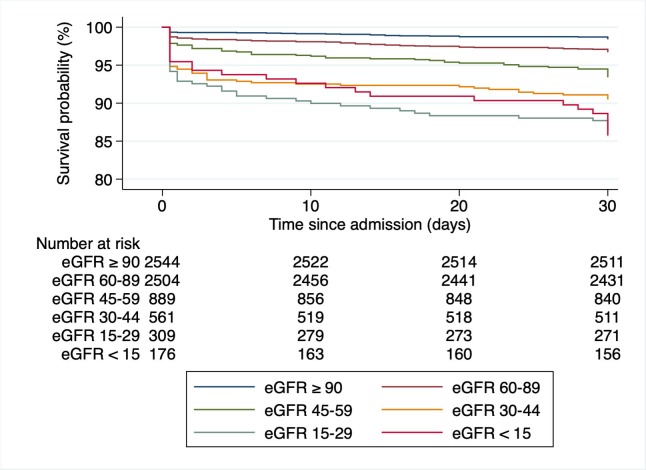
Kaplan-Meier survival estimates by eGFR groups.x-axis, day since admission, y-axis, Proportion of patients alive, eGFR, estimated glomerular filtration rate (ml/min/1.73m2).